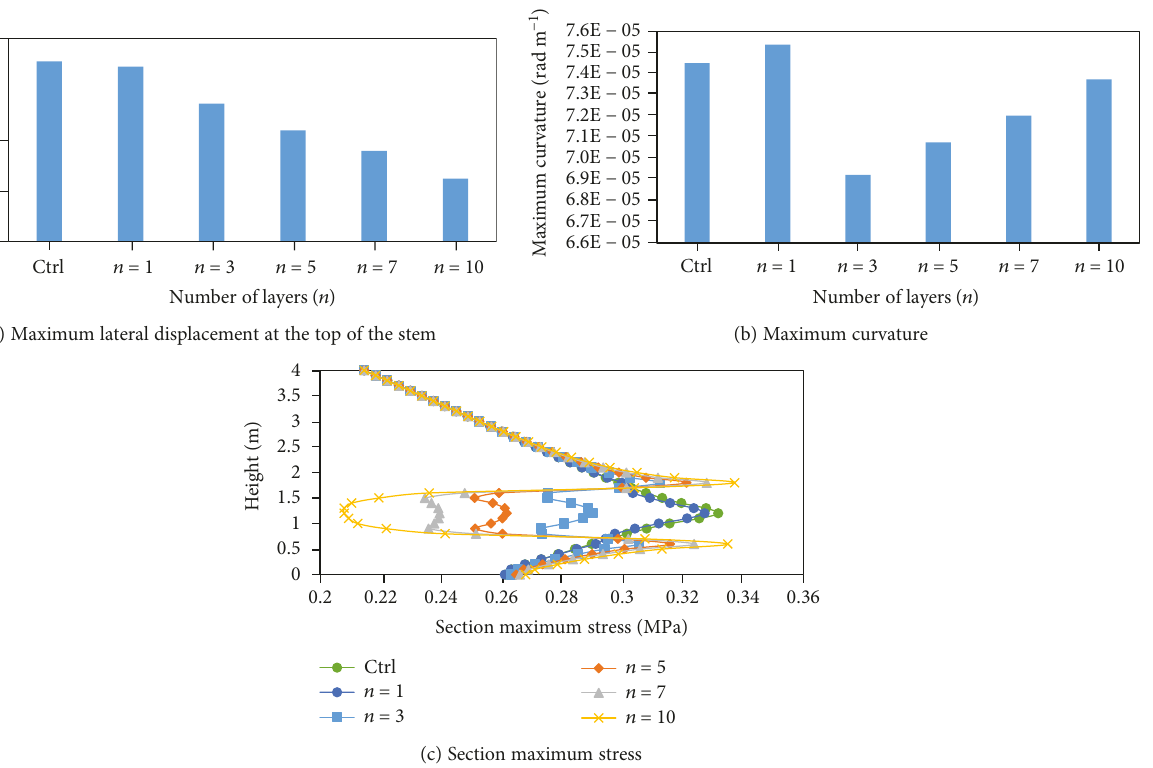
Figure 10: E ff ect of the number of FRP wrap layers: (a) maximum lateral displacement at the top of the stem, (b) maximum curvature, and (c) section maximum